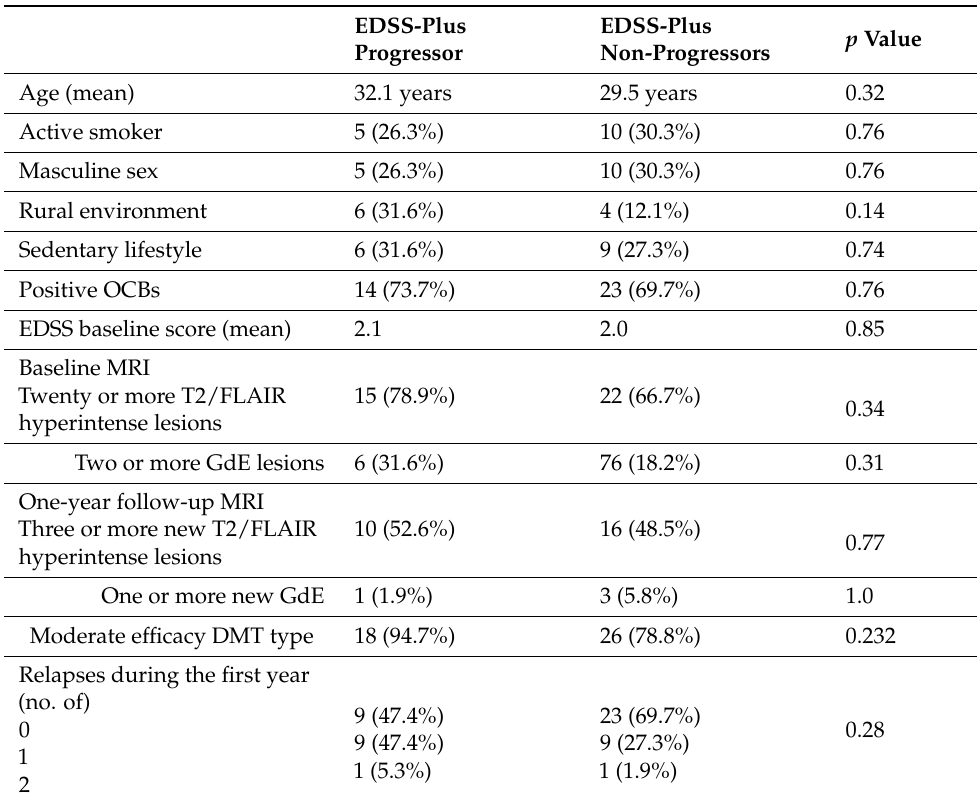
Table 2. EDSS-plus progressor status confounder